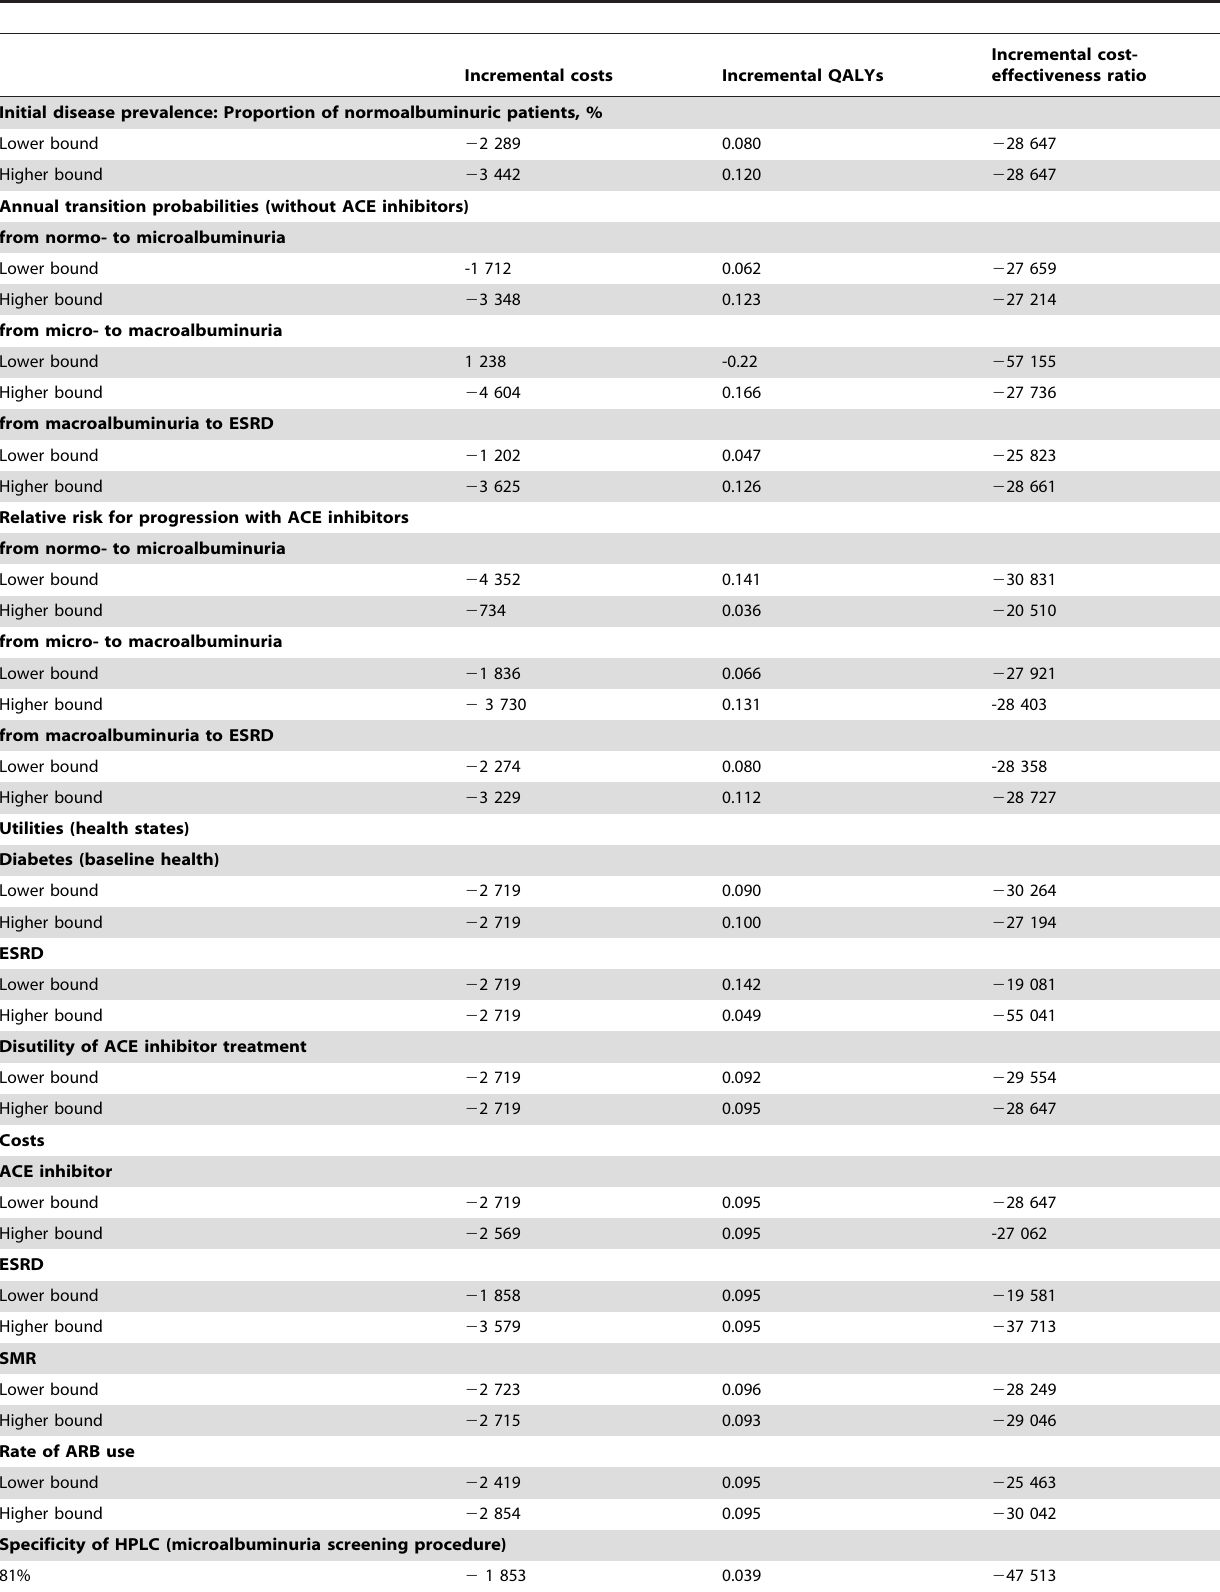
Table 4. Univariate sensitivity analyses: effects of varying base-case estimates on the incremental cost-effectiveness ratio of treating all patients with ACE inhibitors vs screening for microalbuminuria (reference